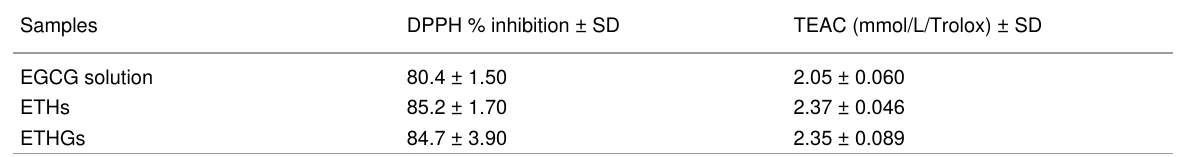
Table 4: The DPPH• and ABTS+• radical scavenging effects of samples a . The antioxidant capacity of the samples was determined via the Trolocks equivalent antioxidant capacity (TEAC) assay.